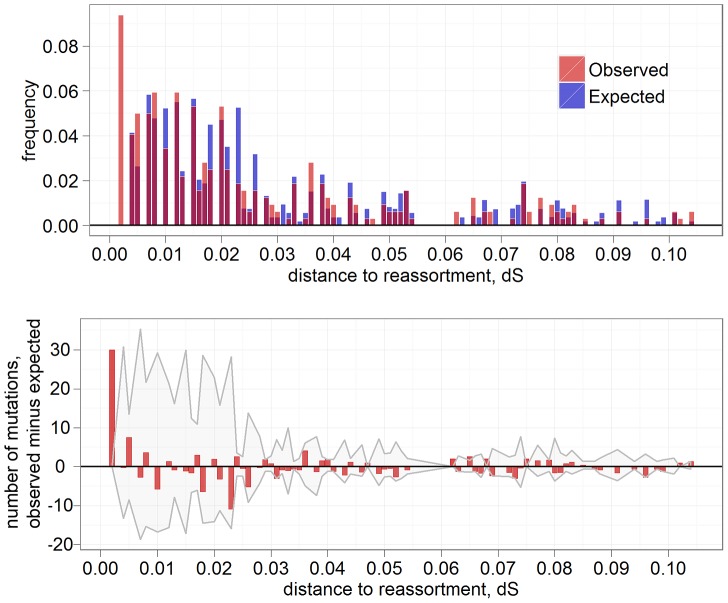
Excess of amino acid replacements after RCBs in NA.Notations as in Figure 2.